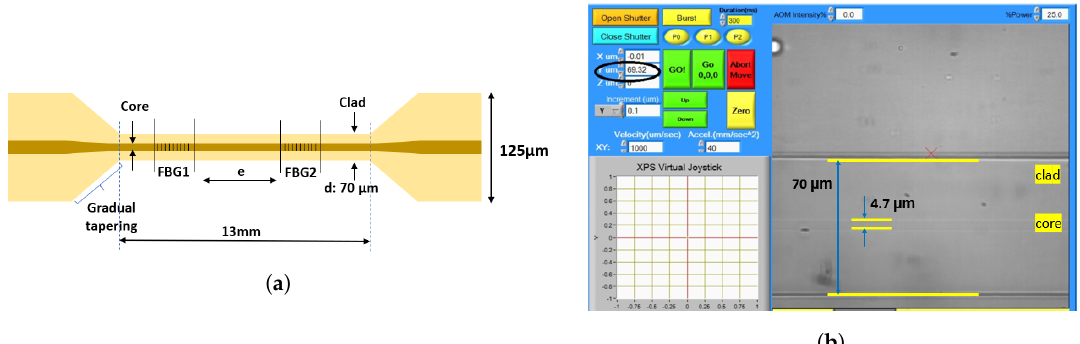
Figure 7. Adiabatic fiber taper: ( a ) schematic; and ( b ) microscopic view of fiber waist after taper.